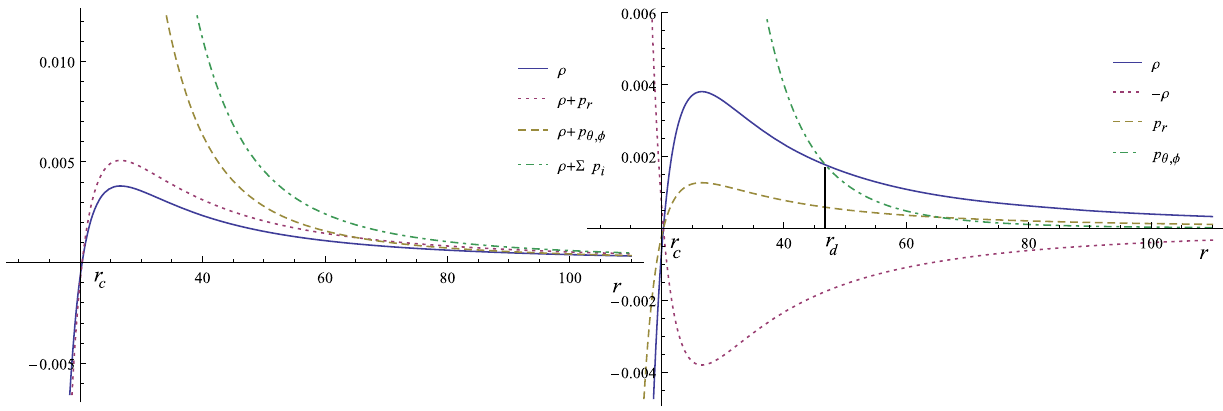
Fig. 2 Energy density, pressures, and their combinations associated to the matter fluid, as functions of the radial coordinate, for λ = 0 . 1, ω = 1 / 3, and r 0 = 20, in natural